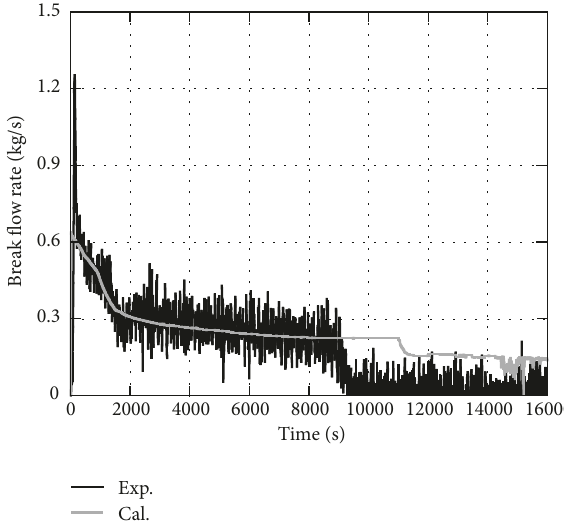
Figure 23: TR-LF-16 test and RELAP5 results for break flow